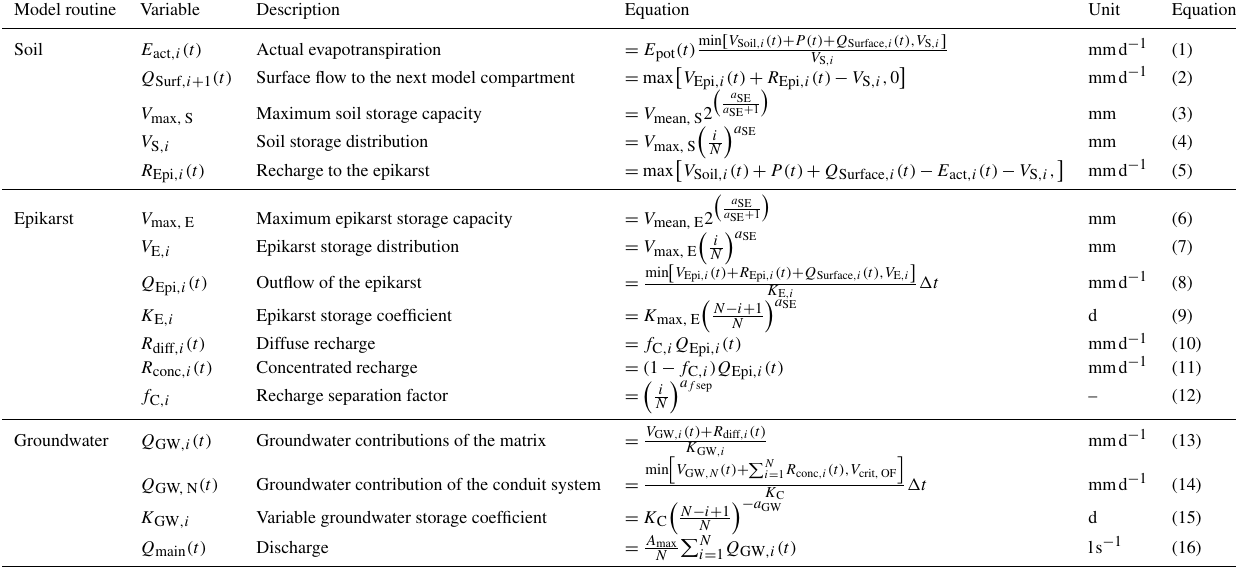
Table A1. Parameters, descriptions and equations solved in the VarKarst model. Model routine